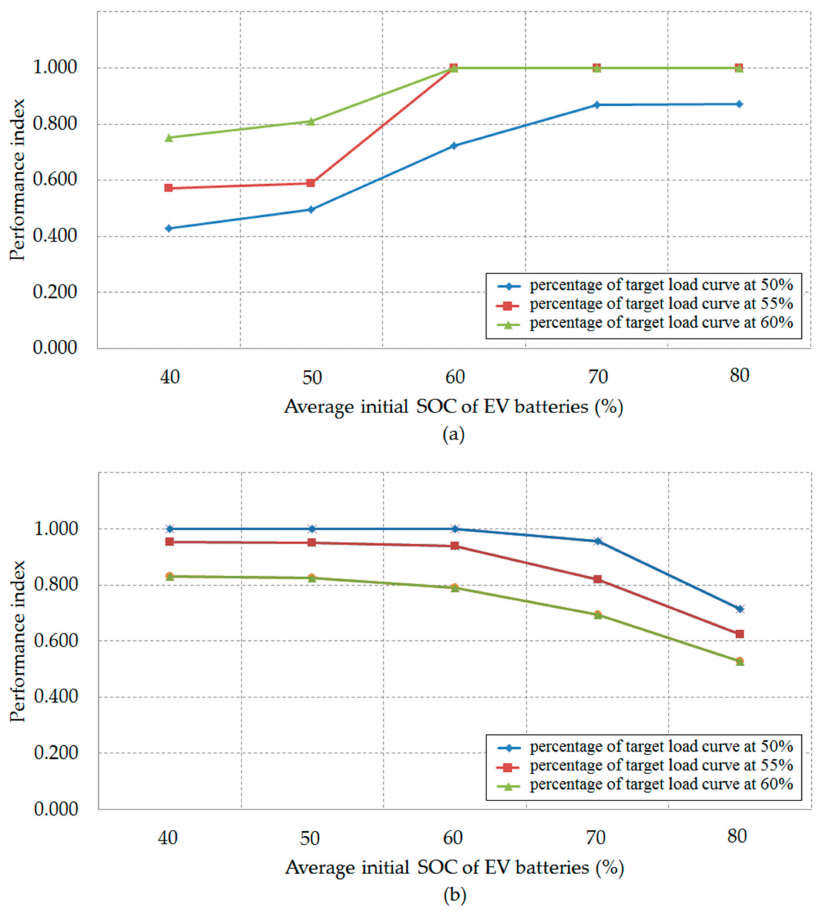
Figure 9. Performance Index under various scenarios: ( a ) peak load shaving and ( b ) load levelling.